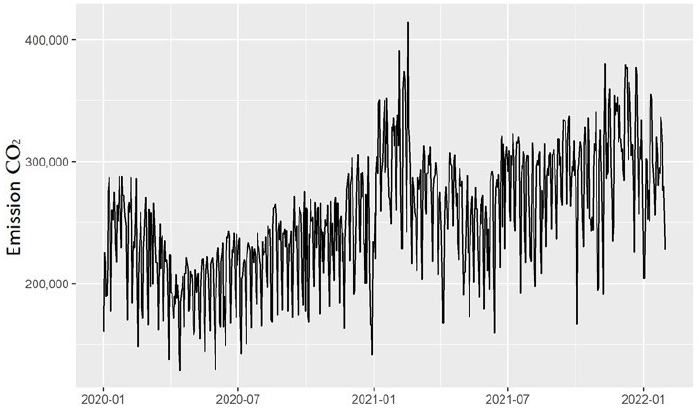
Figure 1. Emission volumes per day.